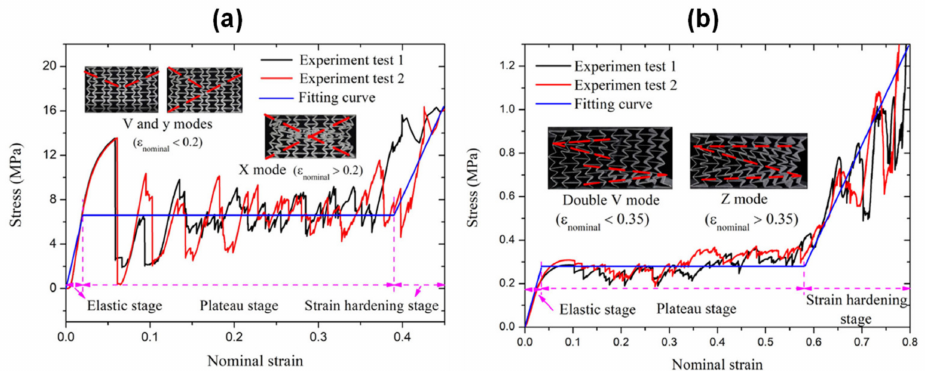
Figure 19. Stress vs. strain of ( a ) Thick-walled; ( b ) Thin-walled re-entrant honeycomb structure [173].